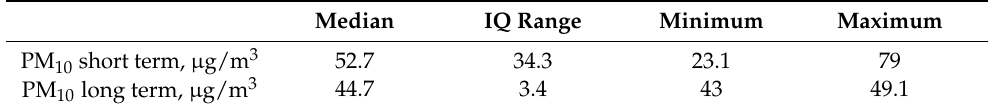
Table 2. Description of exposure to PM 10